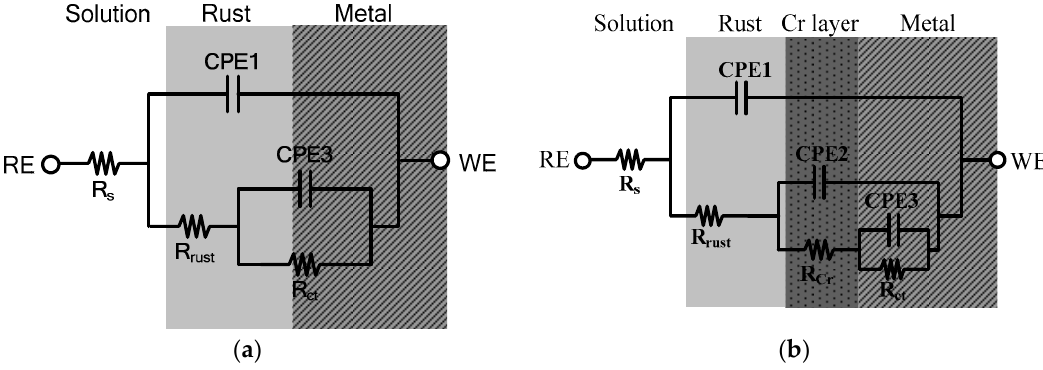
Figure 5. Equivalent circuit models for interpretation of the impedance spectra after 30 days: ( a ) blank steel and ( b ) 0.7-wt.%-Cr steel.